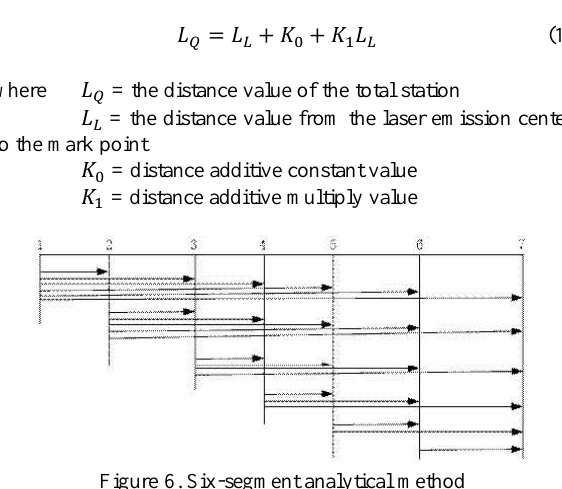
Figure 7. Point cloud result before adjustment